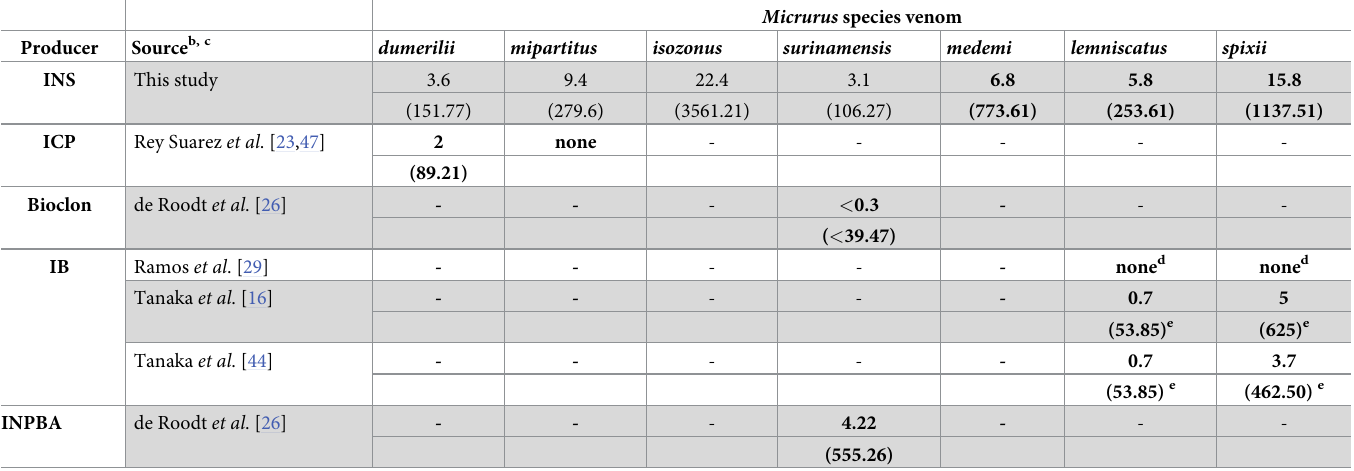
Table 3. Comparative ED 50a values of the coral snake antivenoms distributed in South America, against venoms of the species studied herein.